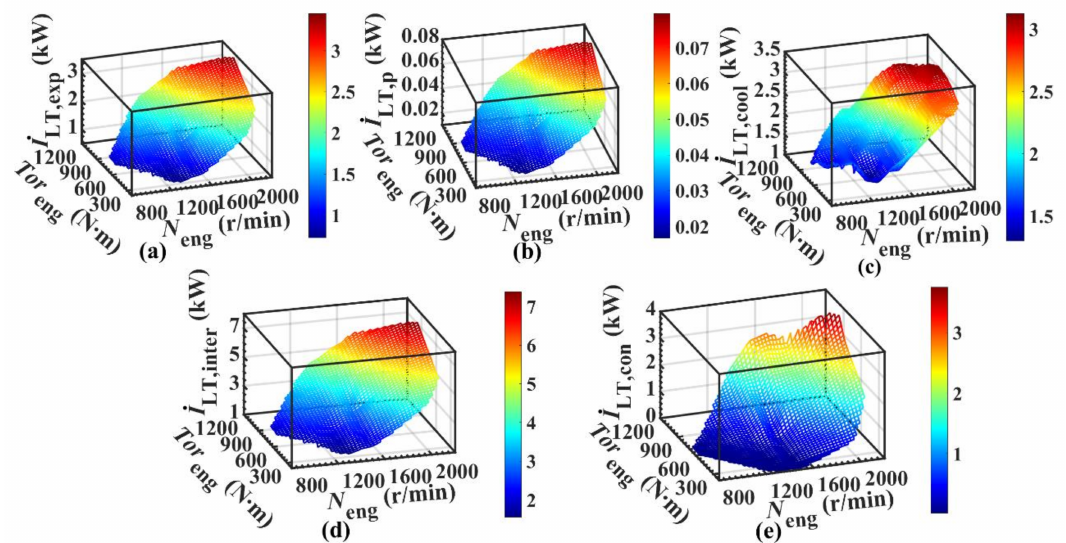
Figure 13. Dynamic response characteristics of exergy destruction of key components in LT loop under full operating conditions. ( a ) dynamic response characteristics of the exergy destruction of the expander in LT loop. ( b ). dynamic response characteristics of the exergy destruction of the working fluid pump in LT loop ( c ) dynamic response characteristics of the exergy destruction of the evaporator in LT loop. ( d ) dynamic response characteristics of the exergy destruction of the intercooler in LT loop. ( e ) dynamic response characteristics of the condenser exergy destruction in LT